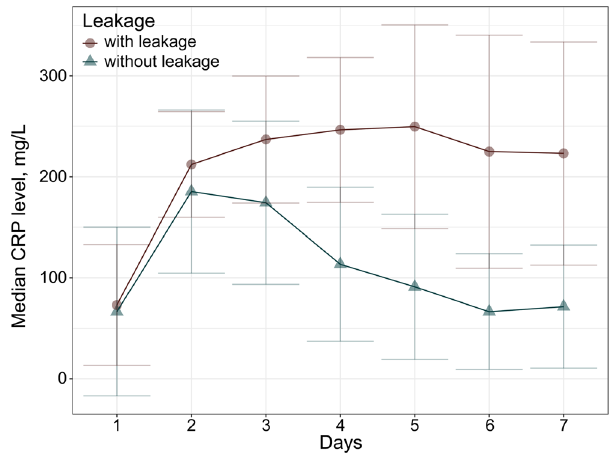
Figure 1. Serum C-reactive protein (CRP) levels in patients with and without primary colic anastomotic